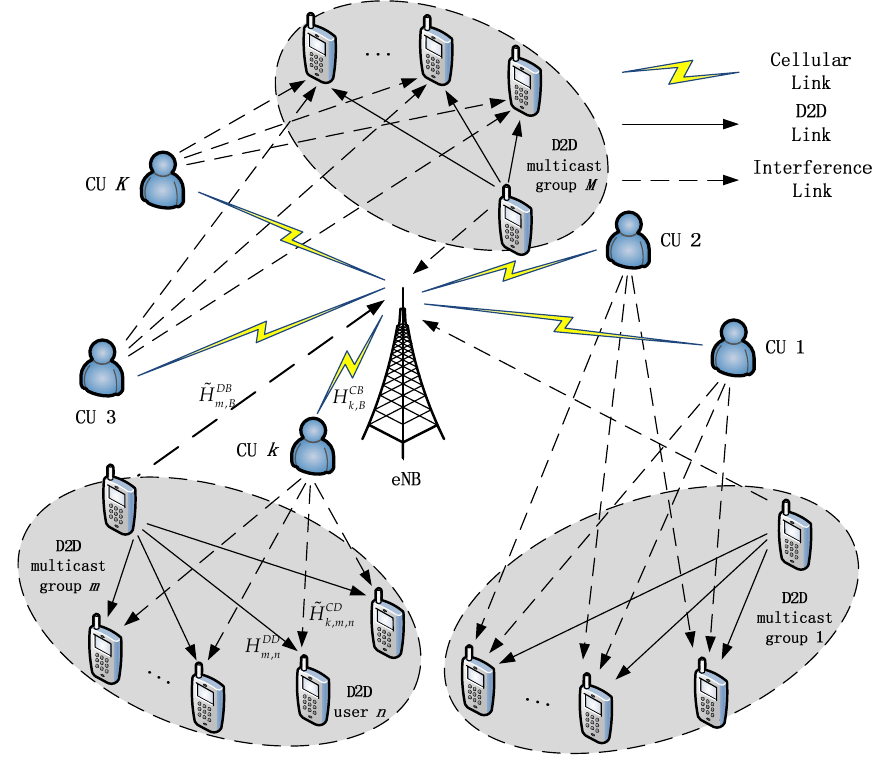
Figure 1. System model of Device ‐ to ‐ device (D2D) multicast groups and cellular uses (CUs). Define a set of binary variables ω m , k with ω m , k = 1 if the m -th D2D group reuses channel k and ω m , k = 0 otherwise. For CU k ∈ K , the maximum transmission power is limited to p C . The signal to interference plus noise ratio (SINR) of eNB on the sub-channel k can be expressed as